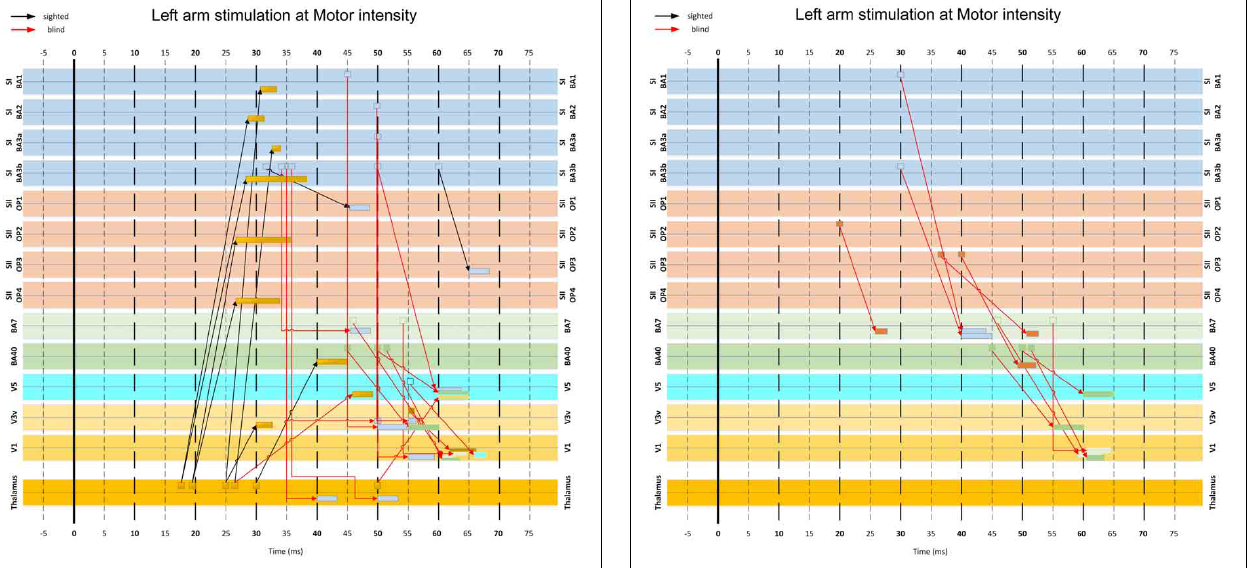
FIGURE 10 | MI-based influence diagram derived from left arm stimulation at Motor intensity. Interregional connection among 14 selected ROIs (indicated at the sides of each row) are shown for sighted (black arrows with MI value threshold c > 0 . 4) and the blind (red arrows with MI value threshold c > 0 . 9) subjects. Arrows indicate the direction of the links in terms of corresponding response latencies and do not necessarily imply causal influence. The base of the arrow indicates the onset latency of the first linked activation. The rectangle pointed by the arrowhead indicates the entire duration of the second linked activation.